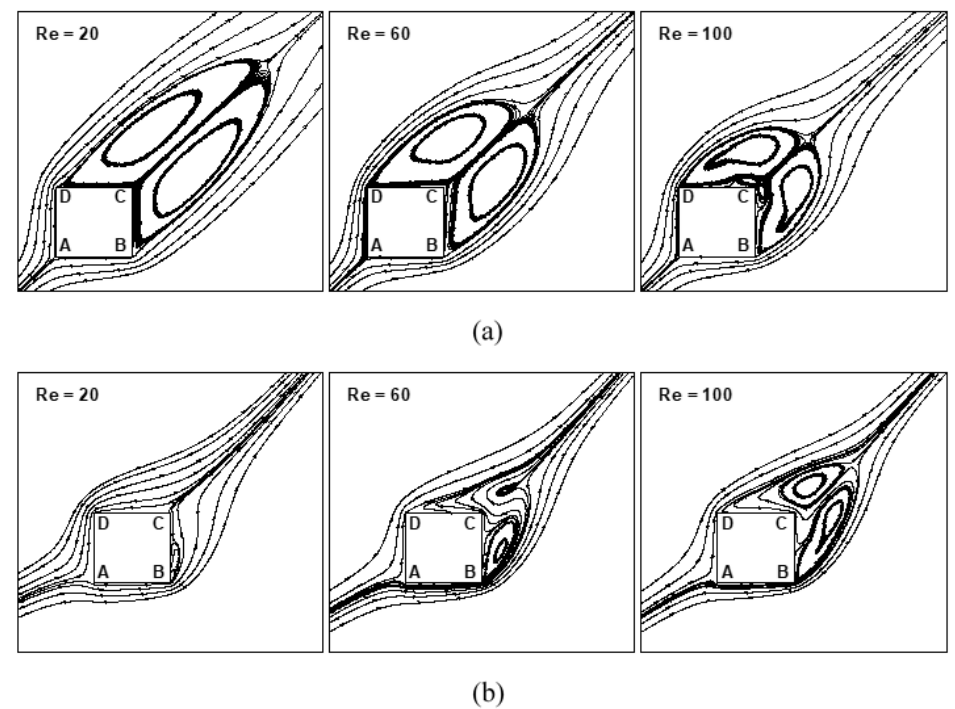
Figure 13. Mean/steady streamline pattern at α = 45 ◦ for Re = 20, 60 and 100 at ( a ) Ri = 0 and ( b ) Ri = 1.6.